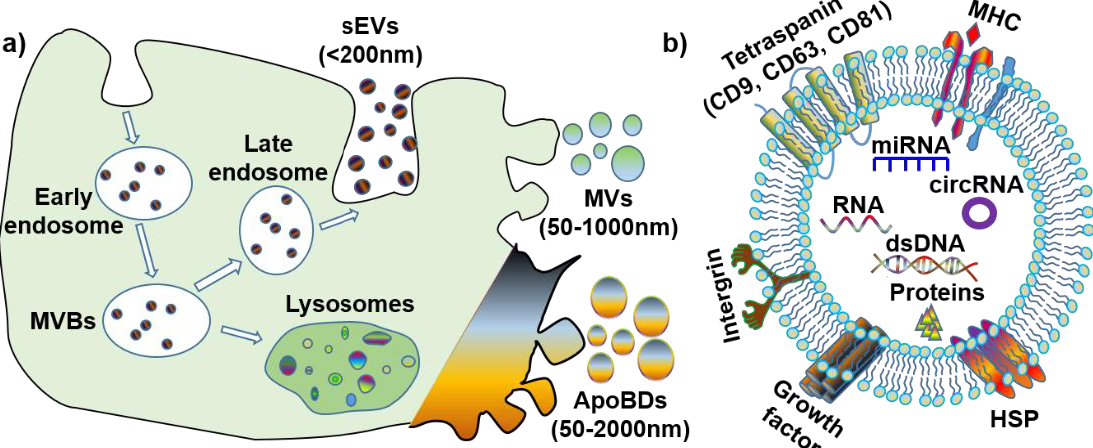
Figure 1. The biogenesis and contents of extracellular vesicles (EVs). ( a ) Biogenesis and size of three EV subtypes. ( b ) Common surface markers and cargos of EVs. sEVs: small extracellular vesicles; MVs: microvesicles; ApoBDs: apoptotic bodies; MVBs: multi-vesicular bodies; MHC: major histocompatibility complex; HSP: heat-shock protein; dsDNA: double- stranded DNA; miRNA: microRNA; circRNA: circular RNA.